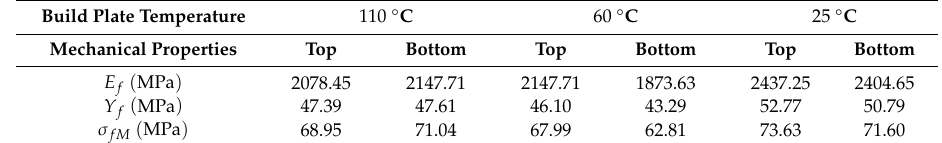
Table 1. Mechanical properties obtained from the bending tests.